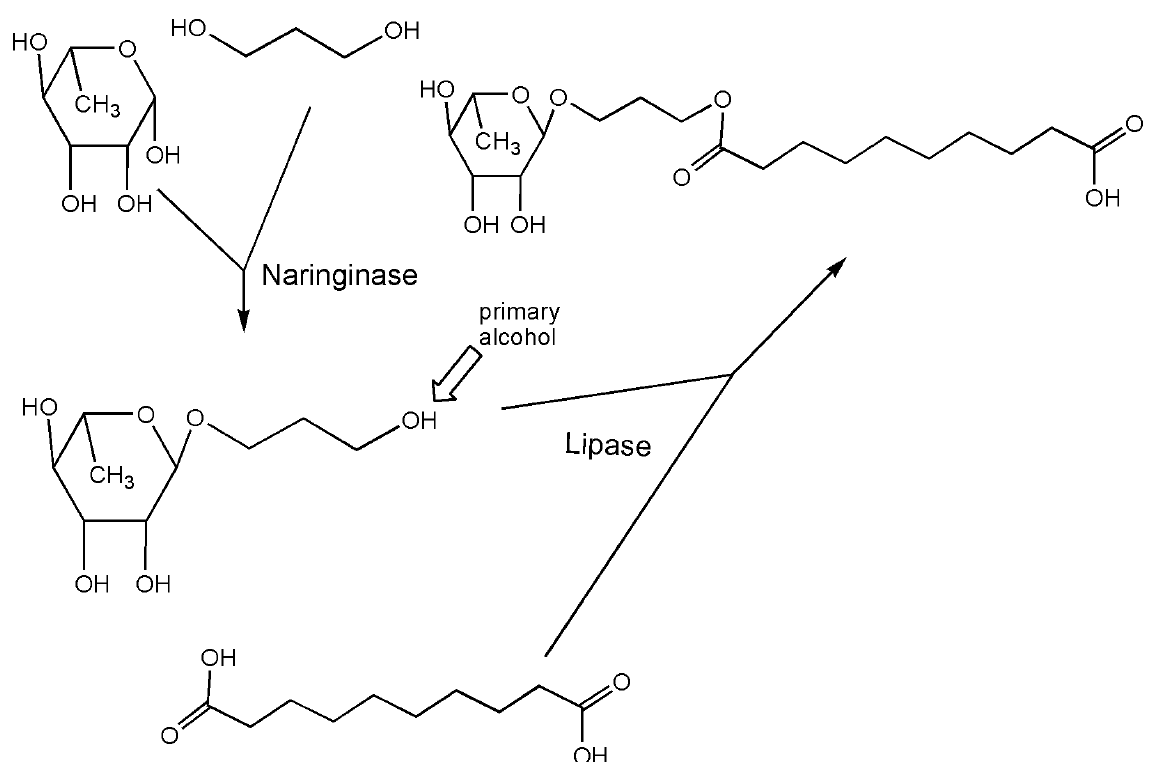
Figure 4. Biocatalytic two-step production of model rhamnolipid-like structures